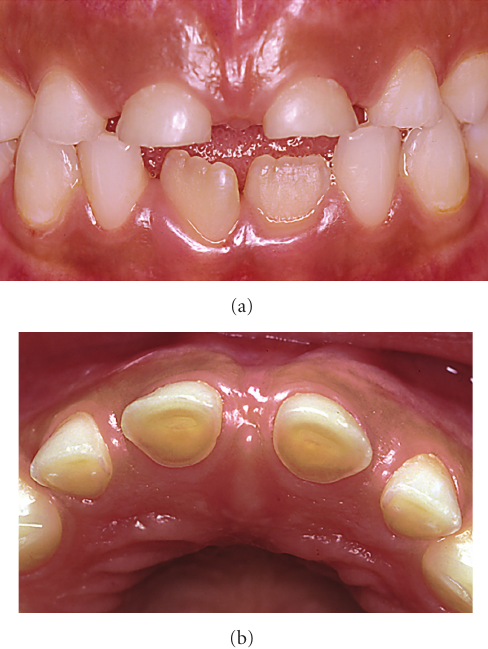
Figure 10: Erosion in the primary dentition in a 6-year-old girl who has high intake of juice, fruit drink, cola, and fruit. (a) Shortening of the crown height on teeth nos. 51–61 as a consequence of dental erosion. (b) Note that the pulp is visible through the remaining tooth substance of teeth nos. 51–61 palatally. Published with permission from the Swedish Dental Journal